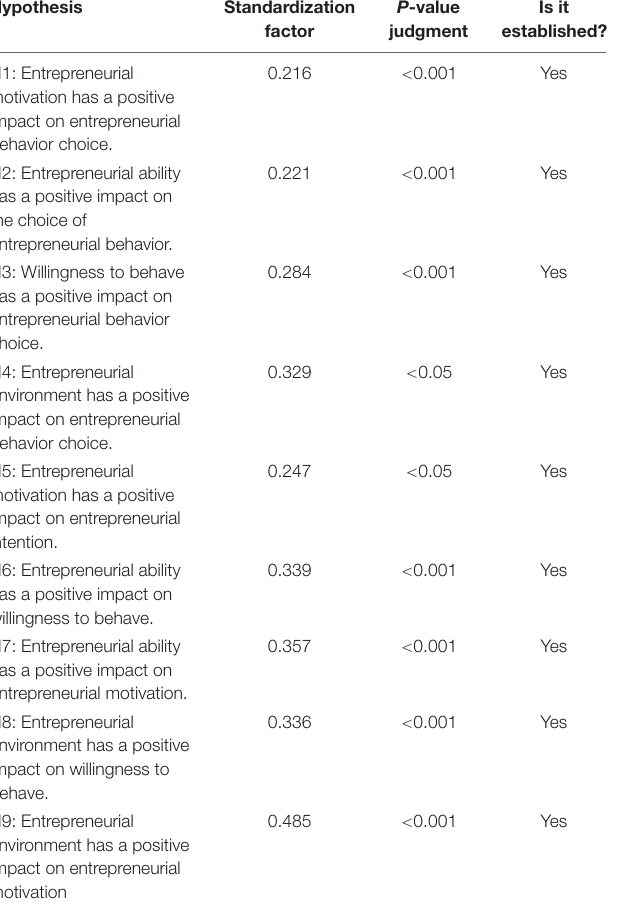
TABLE 4 | Hypothetical judgment. Hypothesis Standardization